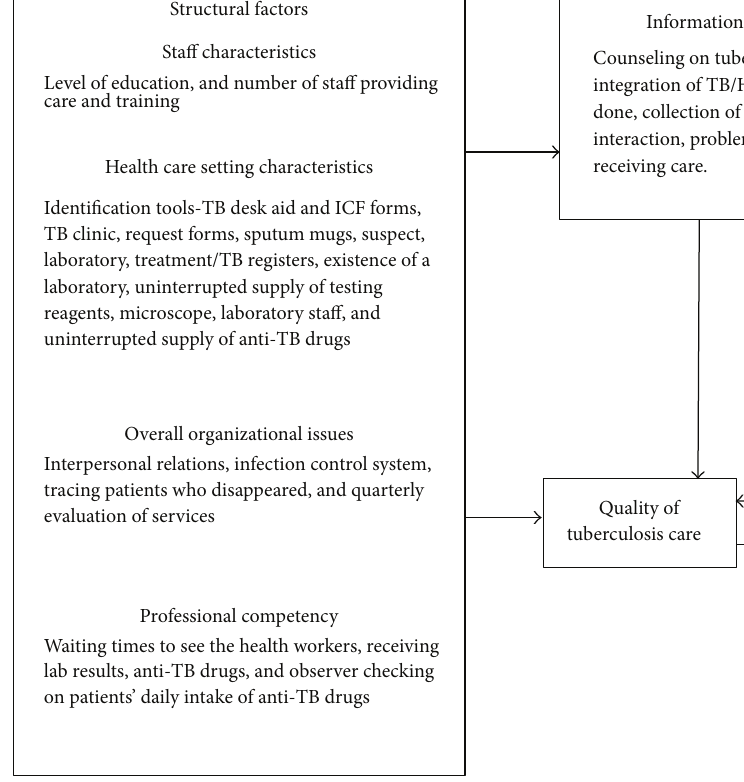
purposively. Tuberculosis patients (suspects or TB